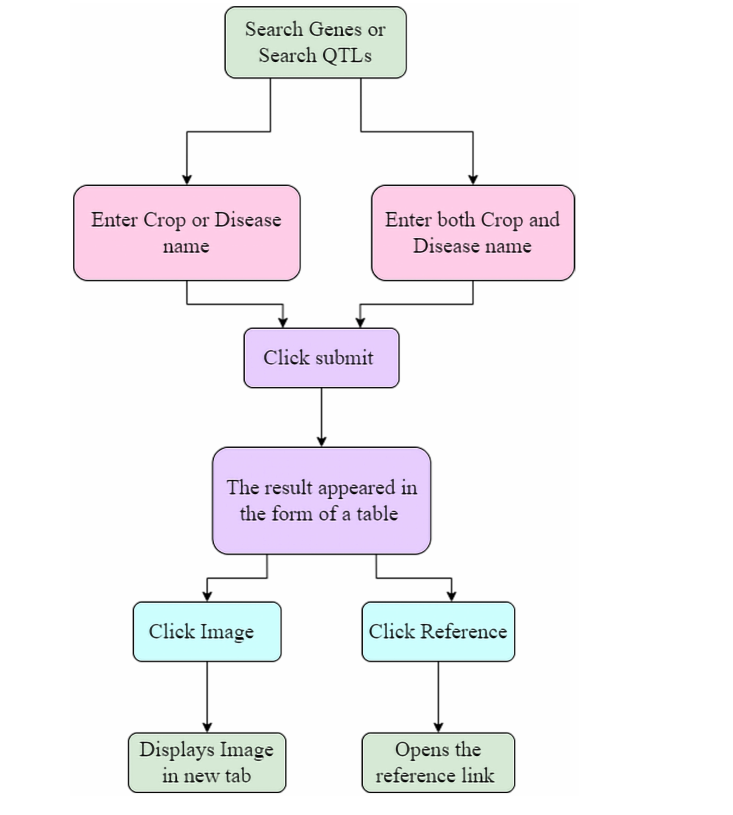
FIGURE 6 Depicting how to utilize the LDRGDb.